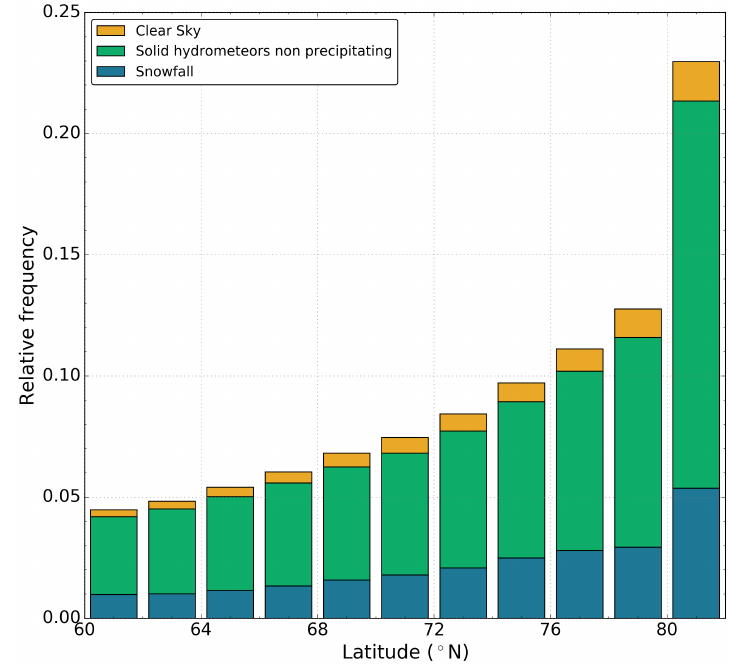
Figure 2. Frequency as a function of latitude for different types of events detected for all profiles of the 2007–2008 Cloud Profiling Radar (CPR)-MHS